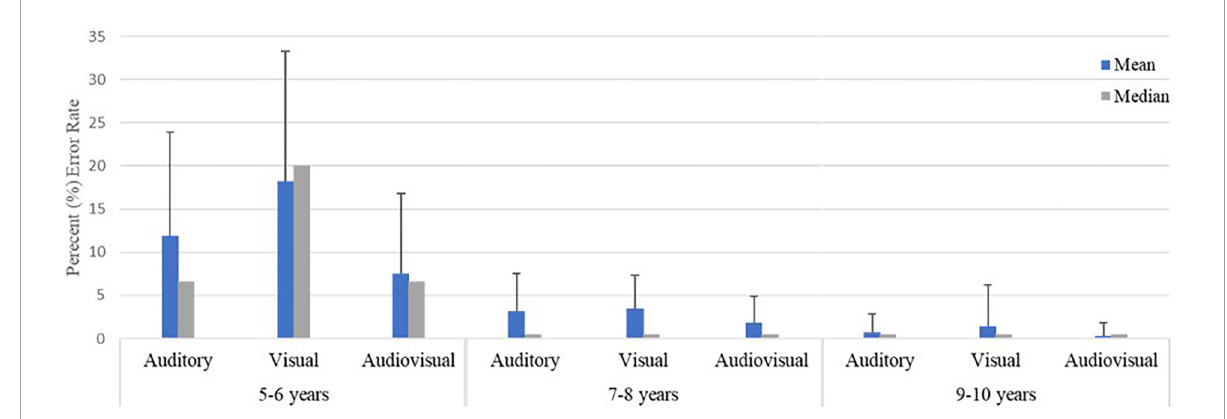
FIGURE6 Median and mean ( ± SD) percentage error (%) for the three trial conditions auditory (AS), visual (VS), and audiovisual (AVS) stimuli.